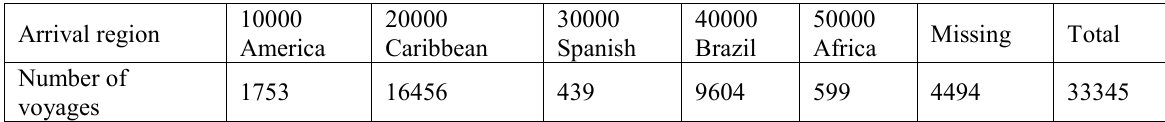
Table 5. WHCDB-2017 voyages by arrival region, 1650s to 1860s.